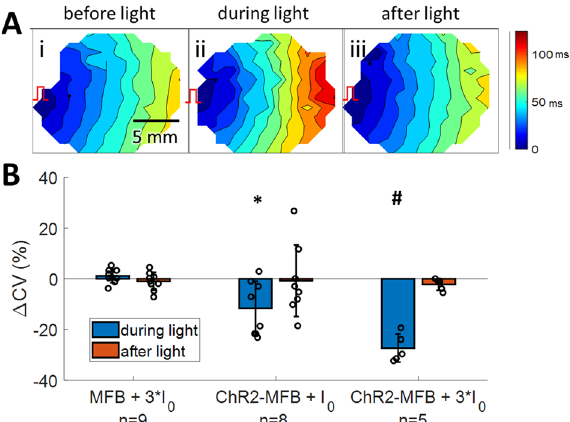
Figure 3. Inward current in myofibroblasts causes slowing in co-cultured cardiomyocyte syncytia. ( A ) Activation maps of a co-culture of ChR2-MFBs with CMs before ( i ), during ( ii ), and after ( iii ) application of 3*I 0 blue light to activate ChR2 current in MFBs. Color bar at right shows activation time scale. Isochrones are 10 ms apart. Red pacing marker illustrates location of pacing. ( B ) Percent change (from value prior to light application) in conduction velocity (CV) during and after application of light at different power levels during 500 ms CL pacing, for co-cultures of CMs with MFBs or ChR2-MFBs. Data for 10*I 0 is not shown since almost all samples beat spontaneously with CL less than 500 ms at this intensity. * indicates p < 0.05, # indicates p < 0.005 between ChR2-MFB and MFB co-culture responses during